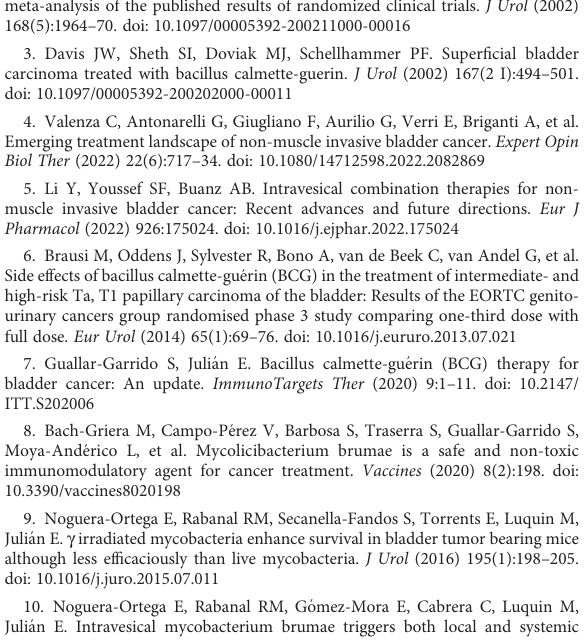
Enriched immune populations into the bladder after M. brumae -A60 treatment. Volcano plots showing adjusted p values versus log (FC) for immune populations in different groups of animals using antibodies panel 1 and panel 2. Populations whose expression is signi fi cantly different with a adjusted p < 0.05 are shown in green. The red line denotes a p value of